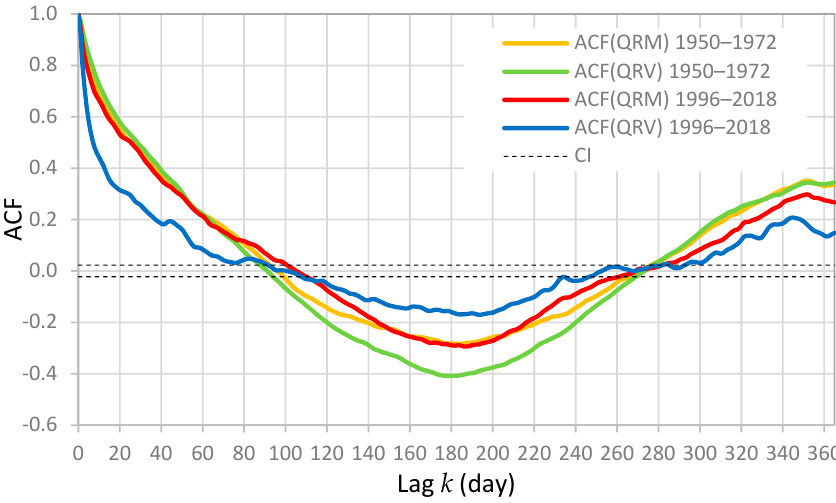
Figure 3. Autocorrelation function (ACF) of discharge for the springs Rumin Mali (Q RM ) and Rumin Veliki (Q RV ) for periods 1950–1972 and 1996–2018. CI—confidence interval.